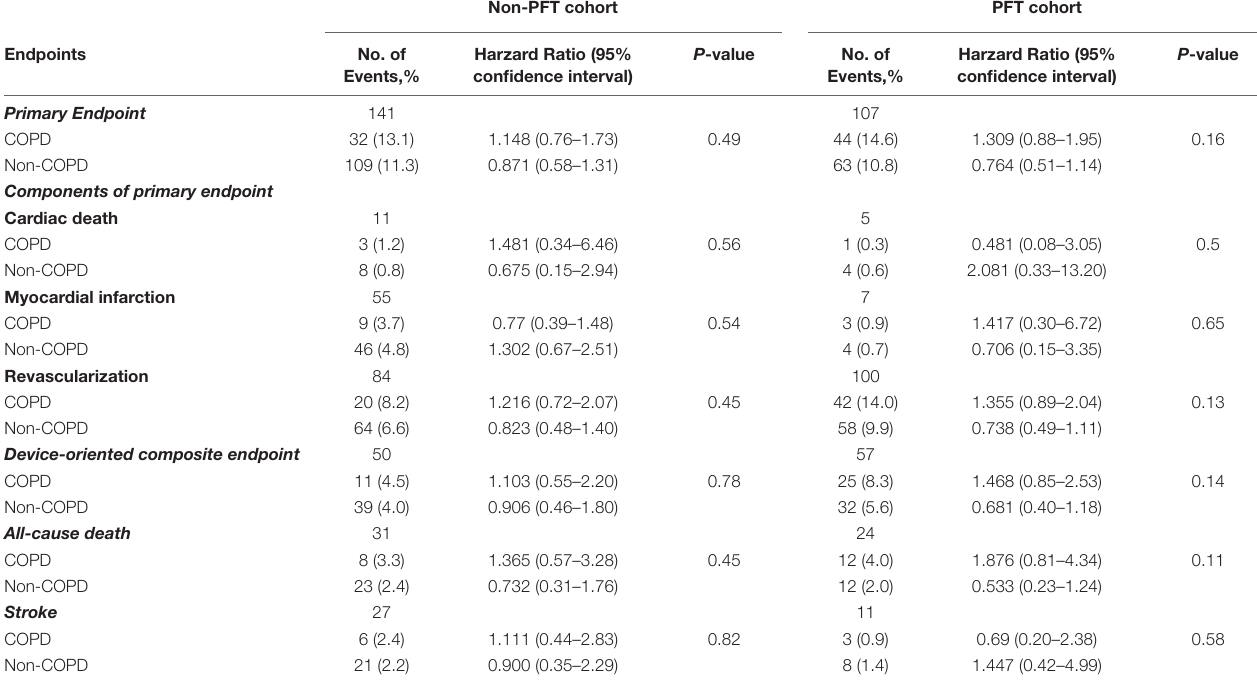
TABLE 1 | Long-term outcomes after PCI in the non-PFT and PFT Cohorts after PSM. Non-PFT cohort PFT